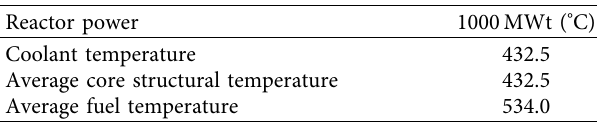
Figure 7: OpenMC model of MET-1000. (a) Top view. (b) Side view. Table 2: Nominal operating